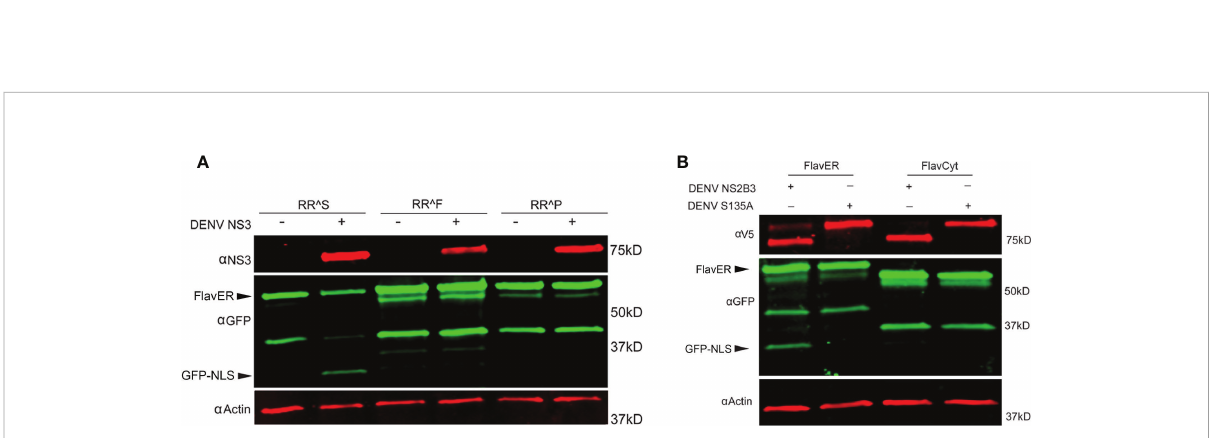
FIGURE 6 FlavER shows intracellular substrate speci fi city for the DENV protease. (A) Immunoblot for NS3, GFP, and actin for U2OS cells expressing the indicated FlavER construct and either left uninfected (mock) or infected with DENV at an MOI of 3. RRS, RRF, and RRP correspond to the residues in the P2/P1/P1 ’ position of the FlavER consensus sequence. (B) Immunoblot of V5, GFP, and actin for U2OS cells expressing FlavER or FlavCyt and transfected with the indicated DENV